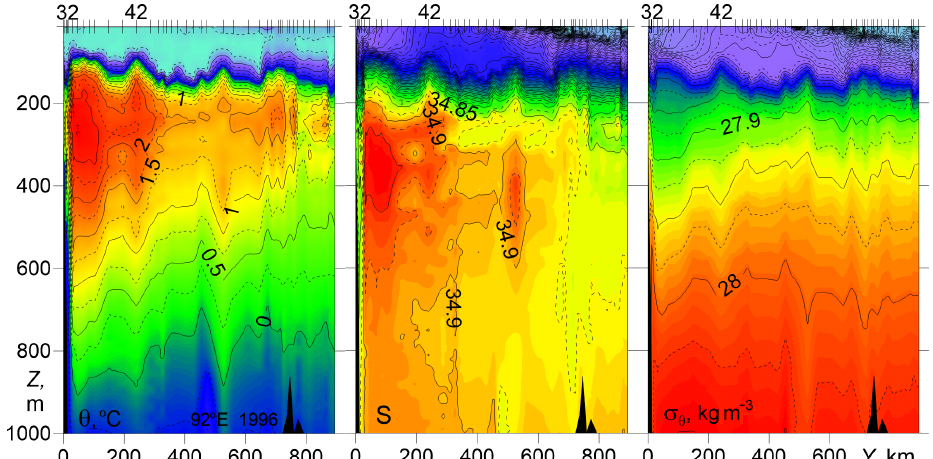
Figure 4. Temperature θ , salinity S , and potential density anomaly σ θ vs. distance and depth for cross-shelf transects at 92 ◦ E (PS96).